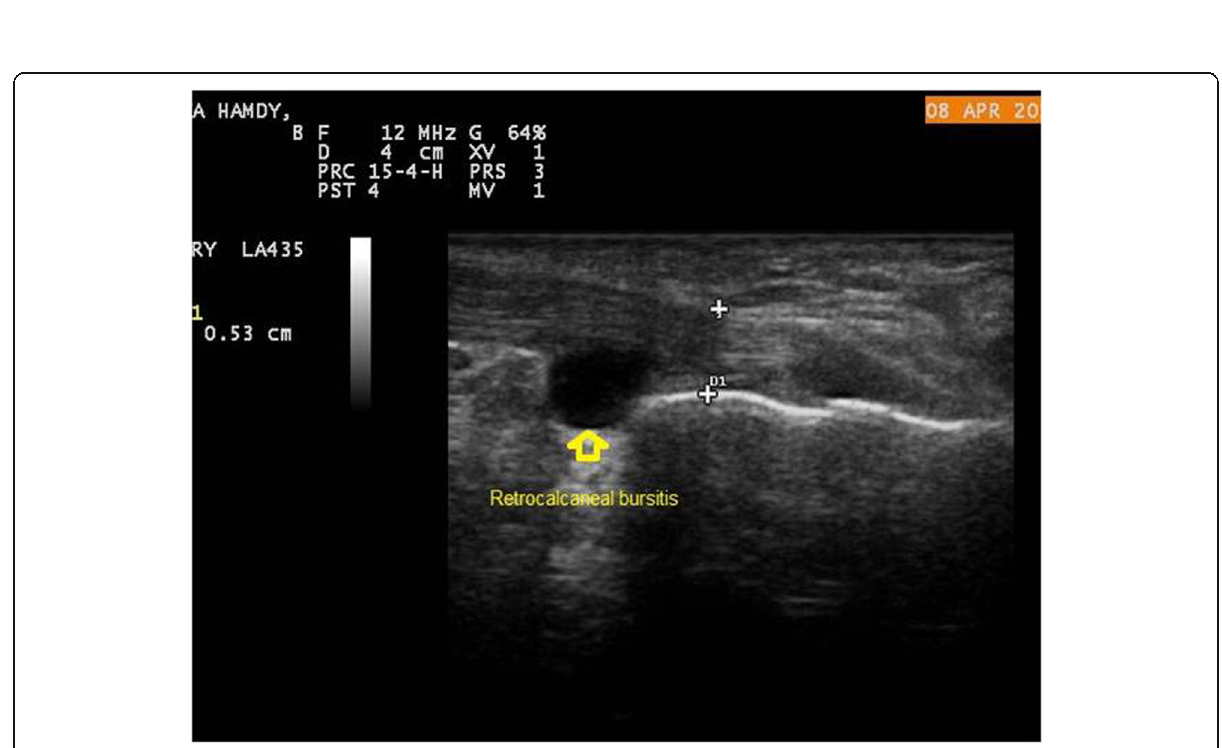
Fig. 6 MSUS of left Achilles tendon of 29-year-old female RA patient showing retro calcaneal bursitis (yellow arrow), increased thickness of Achilles tendon (5.3 mm) and loss of fibrillary